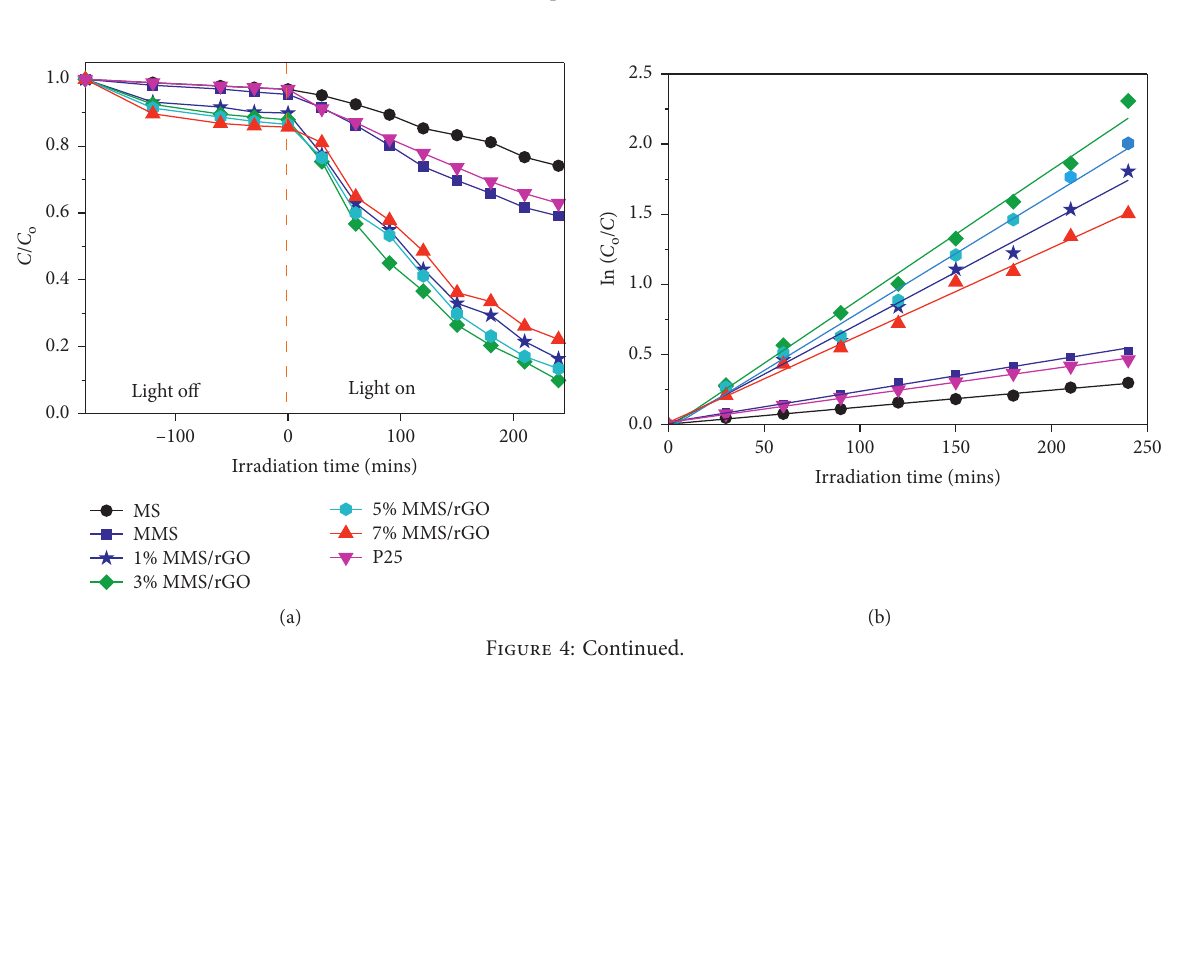
Figure 3: XPS spectra of 3%MMS/rGO.